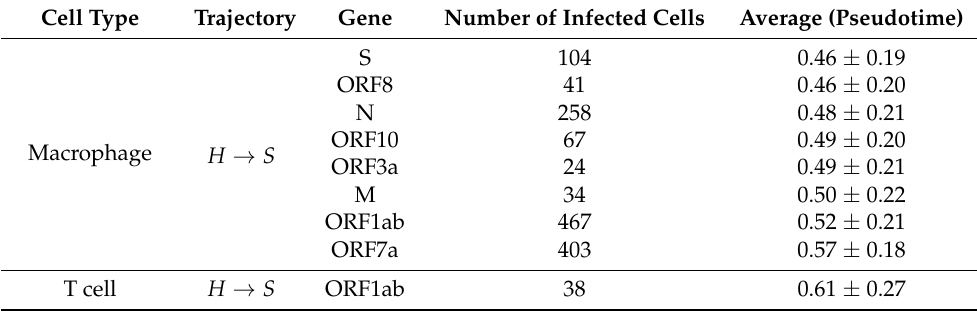
Table 2. The statistics of the SARS-nCoV-2 gene expression across the